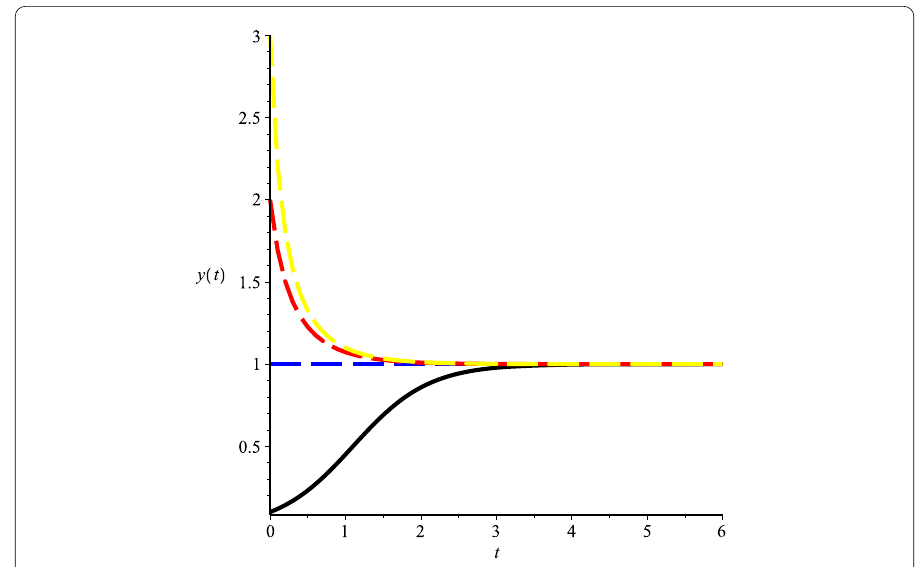
Figure 4 Numeric simulations of the second component of system (5.1), with the initial conditions ( x (0), y (0)) = (5,0.1),(4,1),(0.3,3) and (0.7,2),